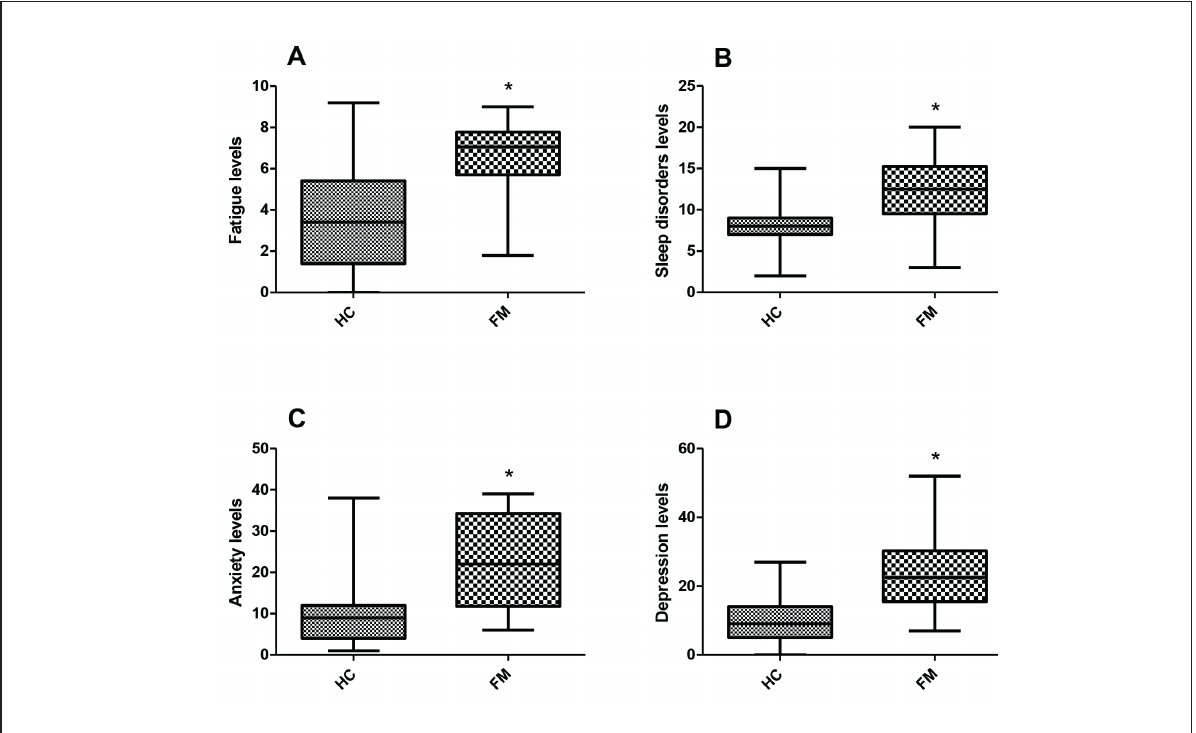
Figure 1 - Boxplot (Whiskers mín-máx) representing the fatigue level, sleep disorders, anxiety, and depression in health con- trols (HC) and in fibromyalgia patients